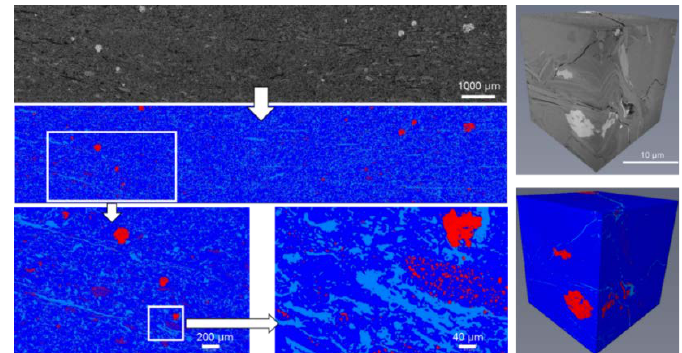
Figure 5. 2D and 3D backscattered montaged image compared to the segmented reconstruction of the Pittsburgh underclay (UC-07). Pores (light blue), matrix (dark blue), and high density and REE-bearing phases (red).